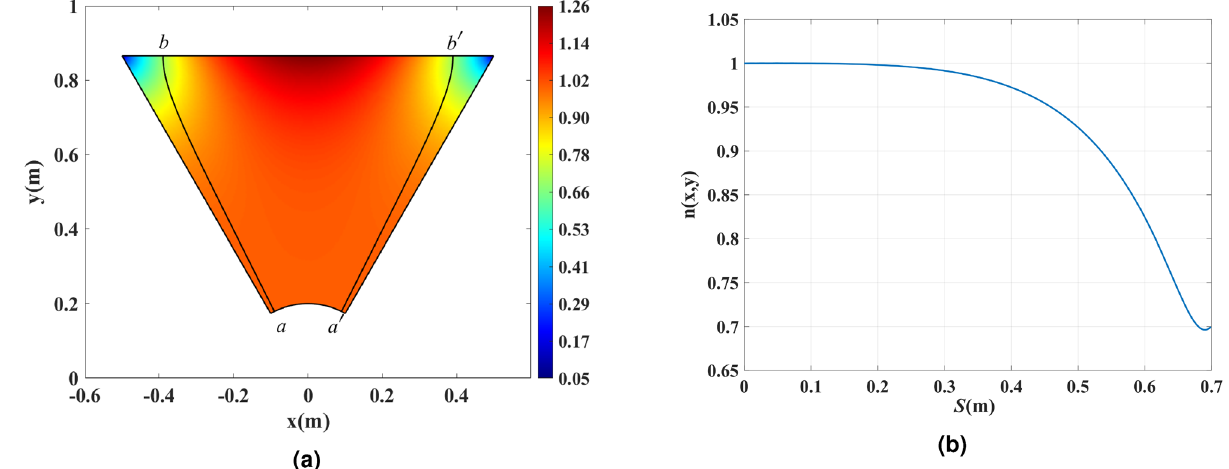
Figure 4. ( a ) The upper π/ 3 radians sector of Fig. 3d hexagon and its refractive index. The ray ab is shown together with its mirror-symmetric ray a ′ b ′ . ( b ) The refractive index versus the optical path length along the ray ab